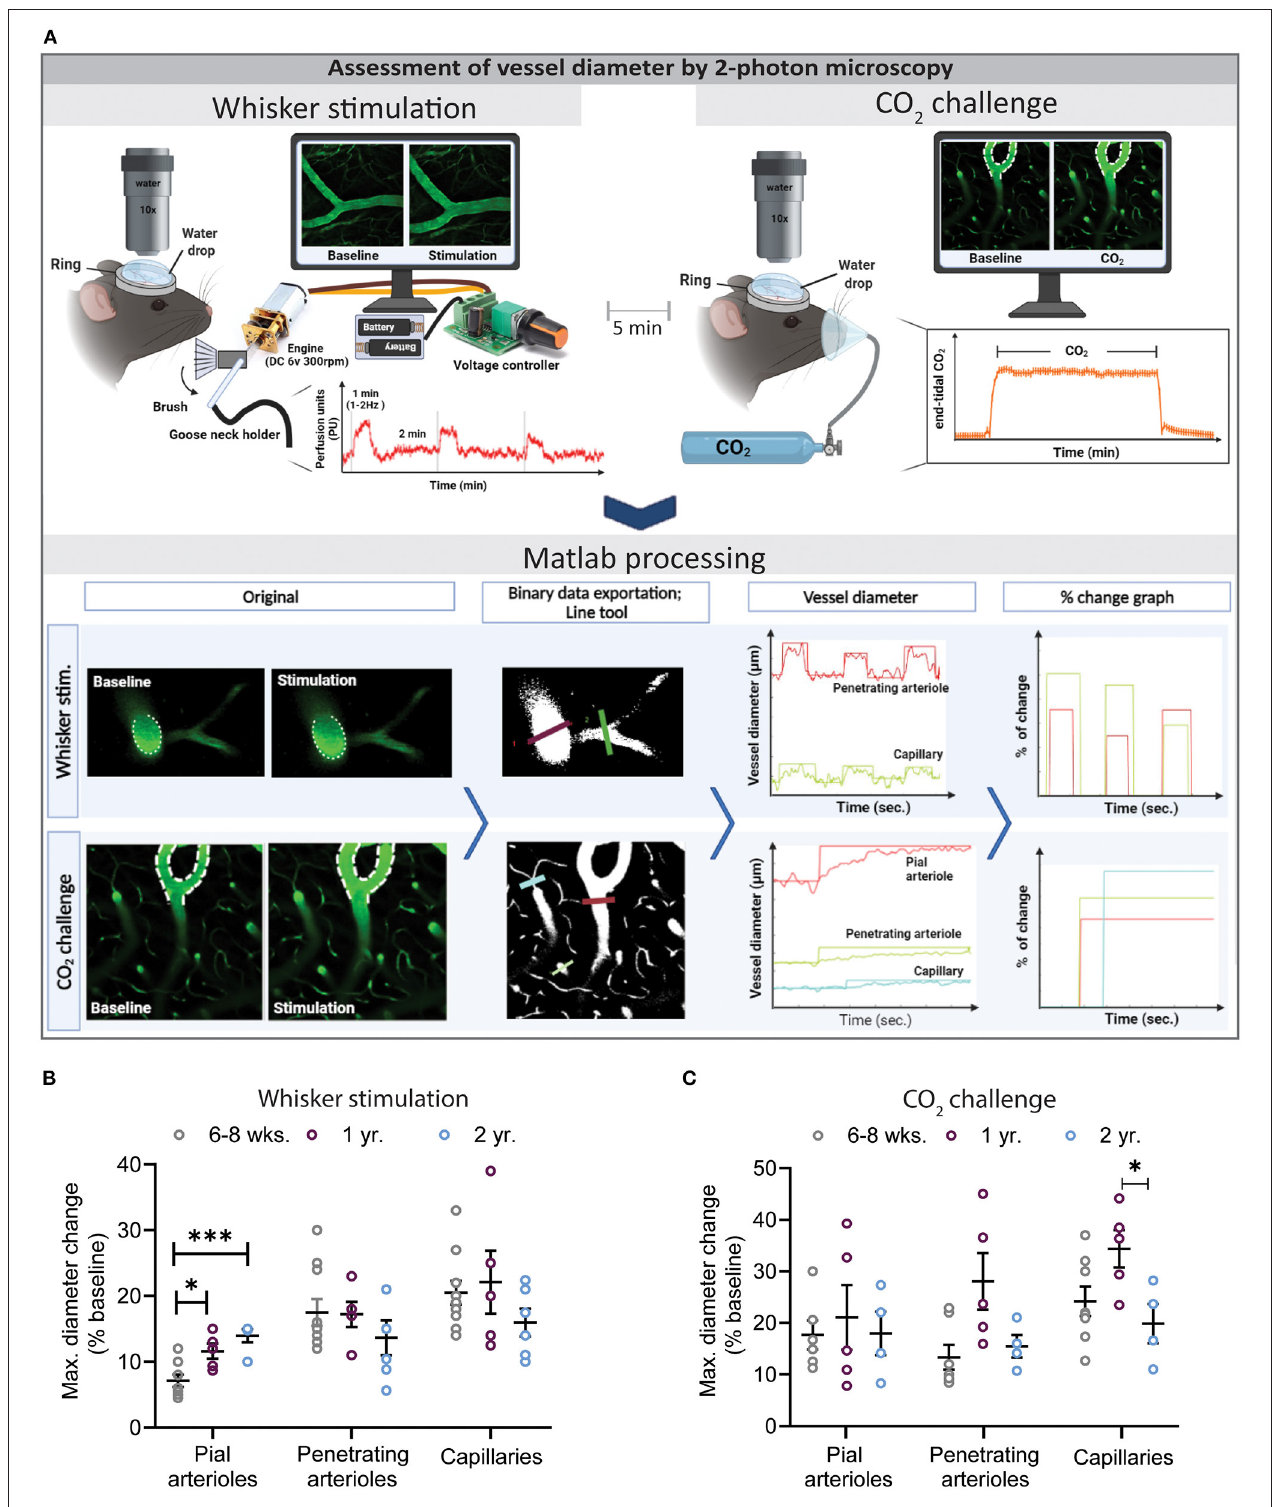
FIGURE 3 | Assessment of vessel diameter by 2-photon microscopy. (A) Experimental setup for whisker stimulation (top left) and hypercapnia during (top right) and a schematic drawing of the data analysis work flow by the newly developed Matlab script. (B) Quantification of maximal diameter changes in different vessel segments at different ages following whisker stimulation. Pial vessel reactivity increased with age (* P < 0.05: 6–8 weeks vs. 1 year and *** P < 0.001: 6–8 week vs. 2 year) while over all the capillary response was reduced in 2-year-old mice in comparison to young and 1-year-old mice. (C) Quantification of maximal diameter changes in different vessel segments at different ages following hypercapnia. Neurovascular reactivity of cerebral capillaries was impaired in 2-year-old mice as compared to 6–8 weeks and 1-year-old mice (* P < 0.05: 1 year vs. 2 year) (mean ± SEM, n = 4–10 mice/group, One-way ANOVA).